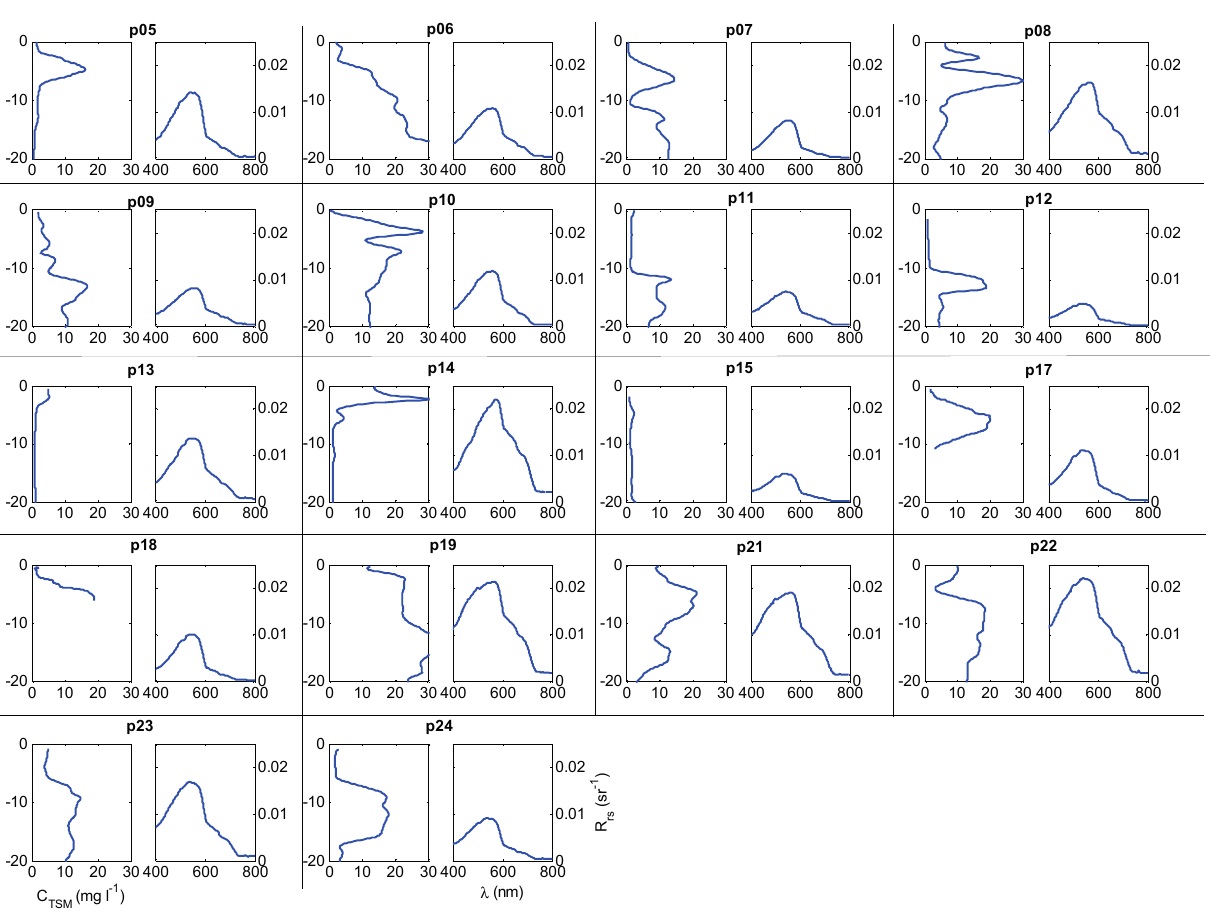
( λ ) ( right ) for all sampling points rs